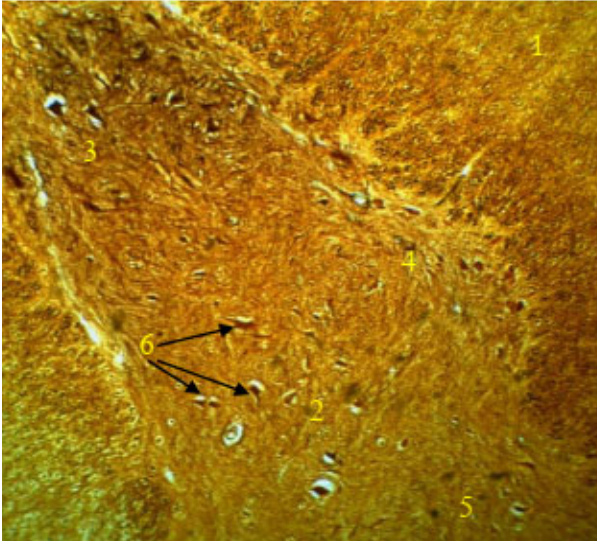
Fig. 2. A fragment of the microscopic structure of the gray matter of the spinal cord of mature cattle: 1 – the body of the neuron; 2 – cell nucleus; 3 – a process of nerve cell; 4 – nuclei of glial cells. Bilshovskym-Gross. × 400